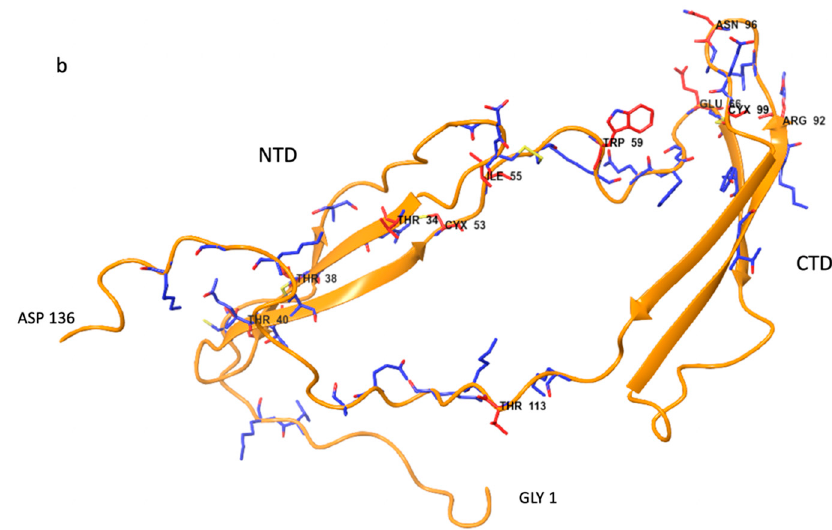
Figure 4. Secondary structure of PTN (pdb 1st model of 2n6f) ( a ) 1 ( b ) 2 complexes with residues highlighted in stick representation, according to the CSP magnitude: (red larger than 0.2, blue larger than 0.1).